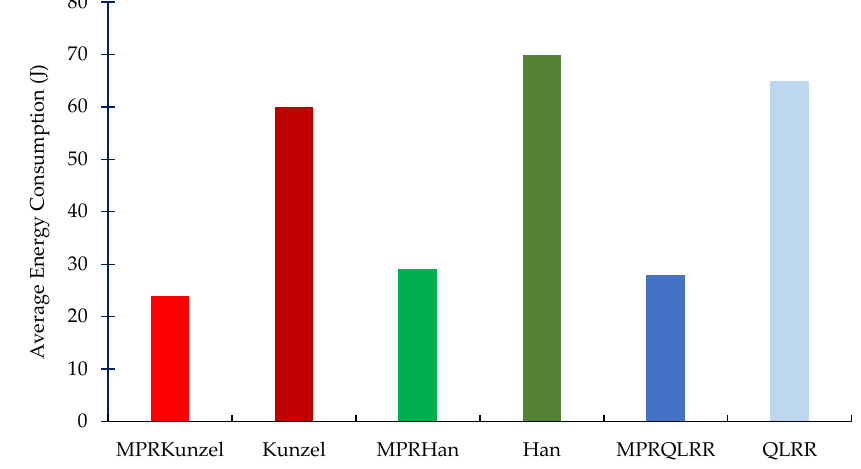
Figure 10. Energy consumption performance